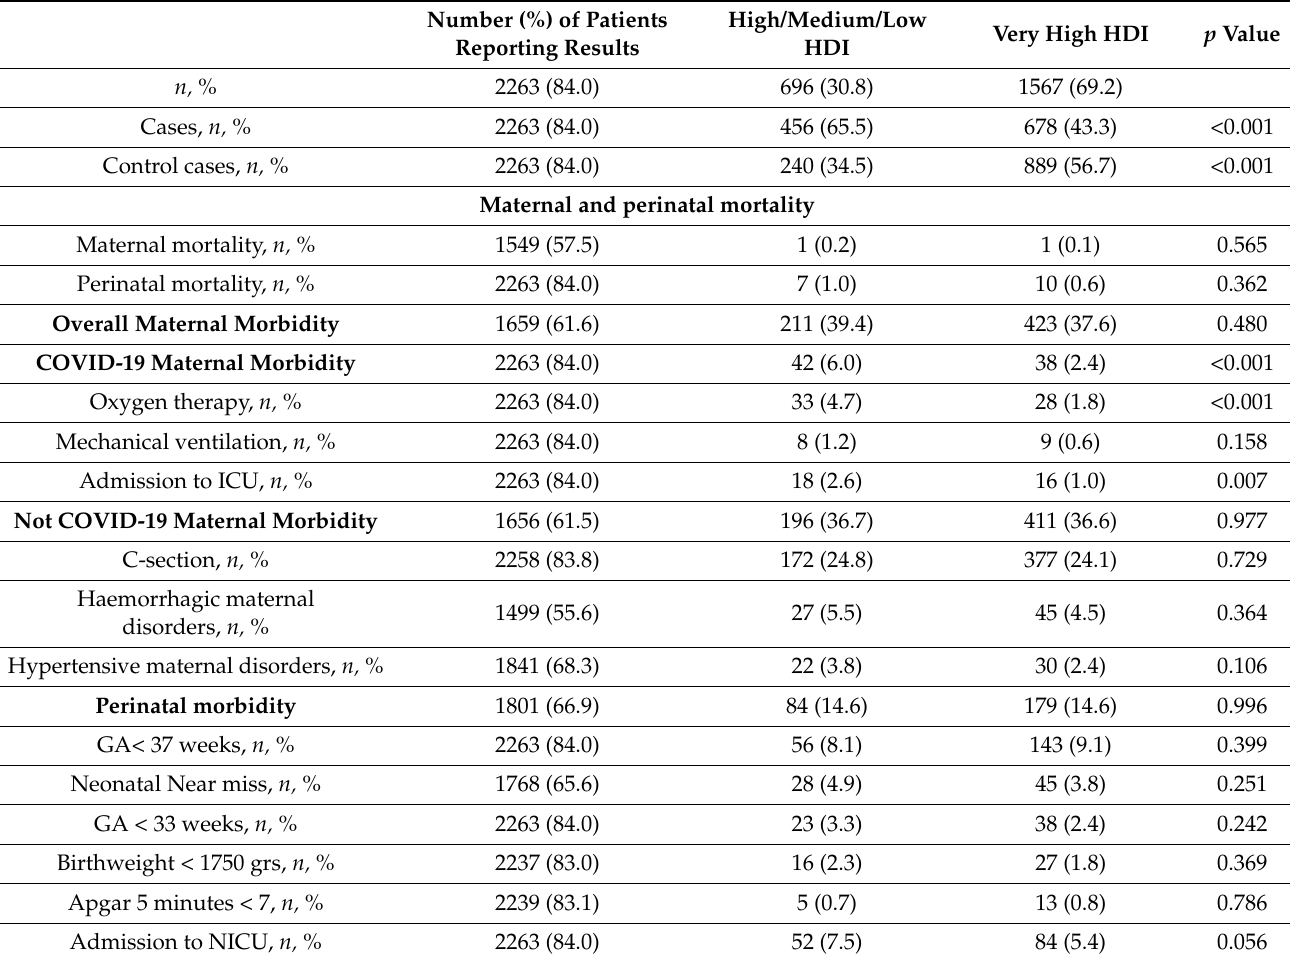
variables overweight and obesity or preexisting and obstetric maternal comorbidities on the relationship between maternal COVID-19 morbidity and HDI group ( p = 0.545). Fur- ther, after correcting for confounding factors, the final model only included the qualitative variable HDI, such that coming from a country in HDI groups 2–4 was related to 2.6 times